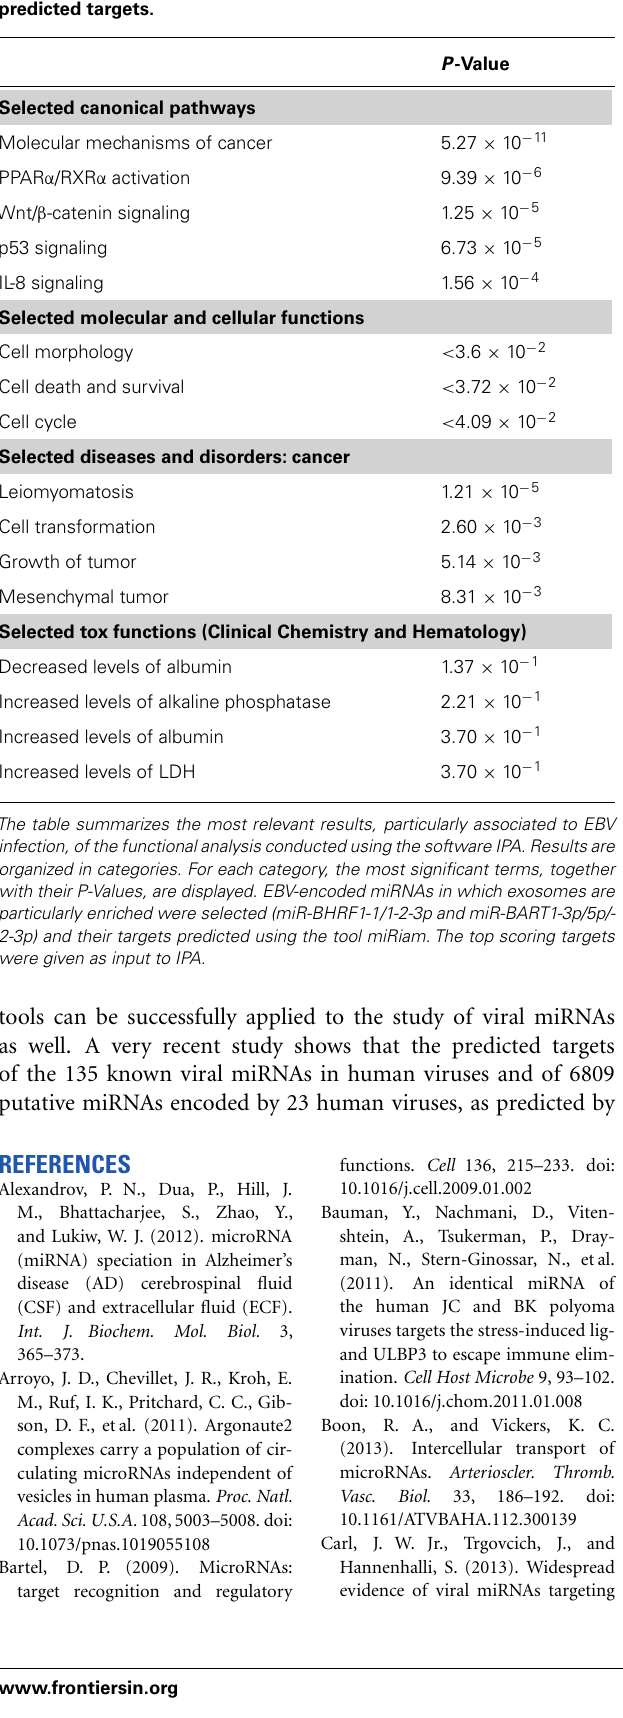
Table 1 | Functional enrichment analysis of circulating EBV miRNAs’ predicted